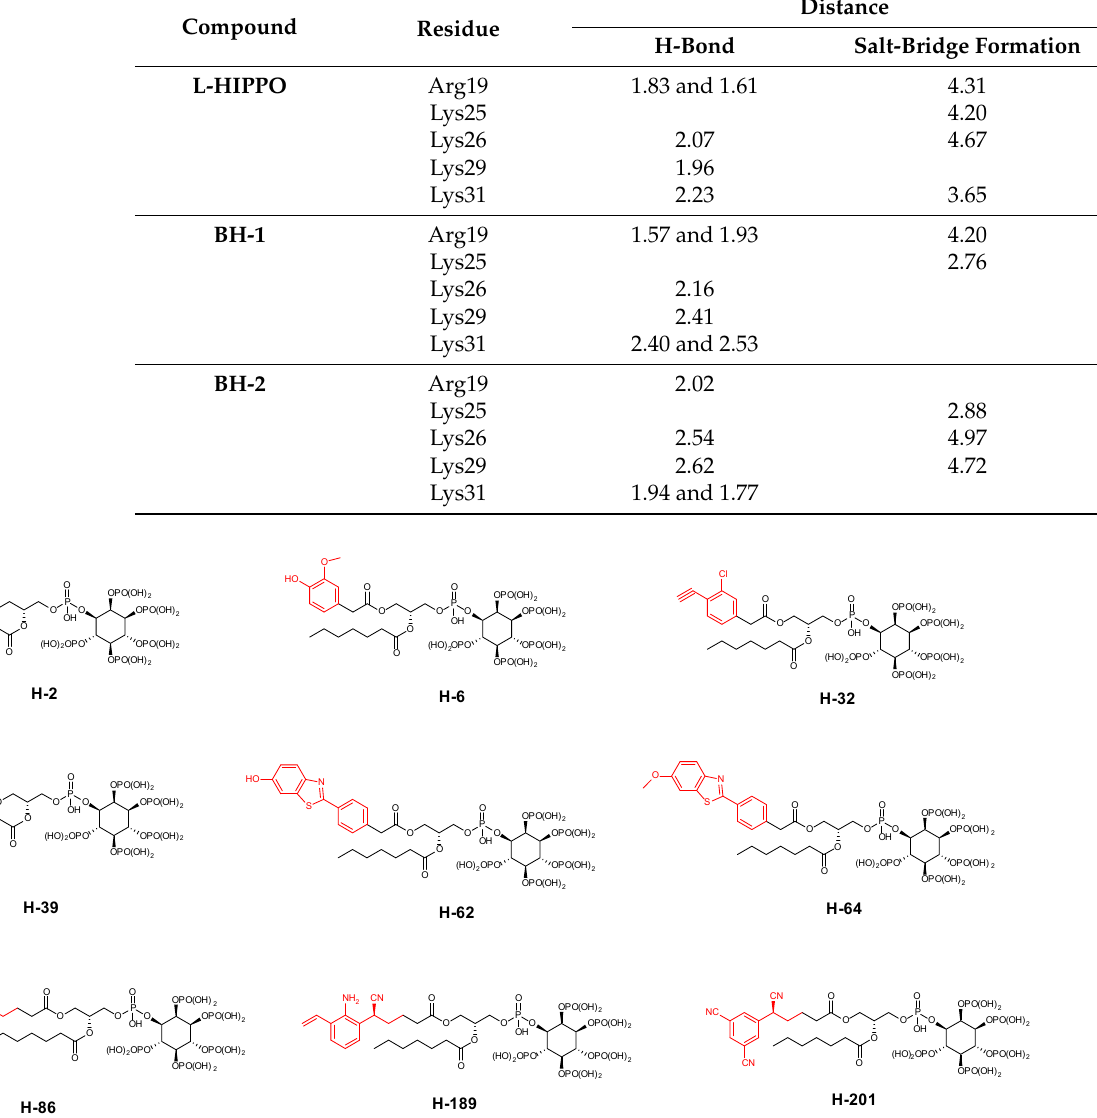
Figure 6. Aromatic group ‐ based new L ‐ HIPPO derivatives.